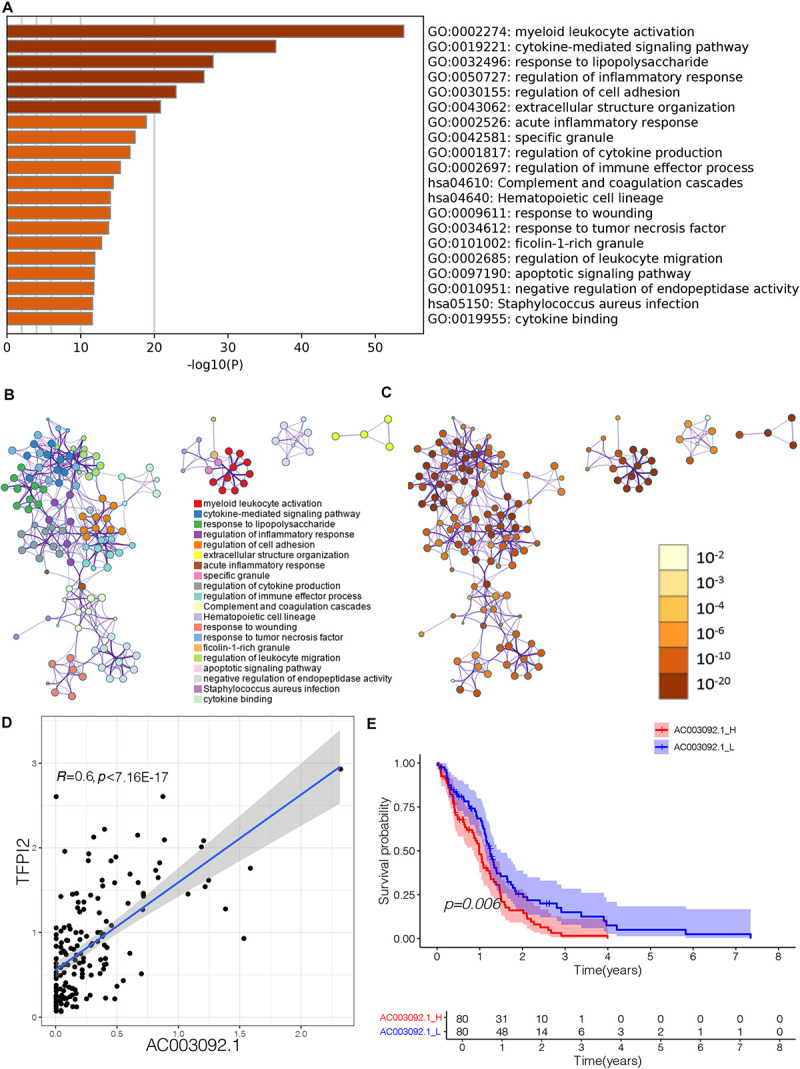
Effect of lncRNA AC003092.1, as an immune-related gene, in GBM. (A) Heatmap of enriched terms across input gene lists, colored by p values. (B) Enriched terms colored by cluster ID, where nodes that share the same cluster ID are typically close to each other in AC003092.1-related genes. (C) Enriched terms colored by p value, where terms containing more genes tend to have a more significant p value in AC003092.1-related genes. (D) Scatterplot showing the correlation between AC003092.1 and TFPI2 levels. (E) Comparison of overall survival between AC003092.1_H and AC003092.1_L by log-rank test.